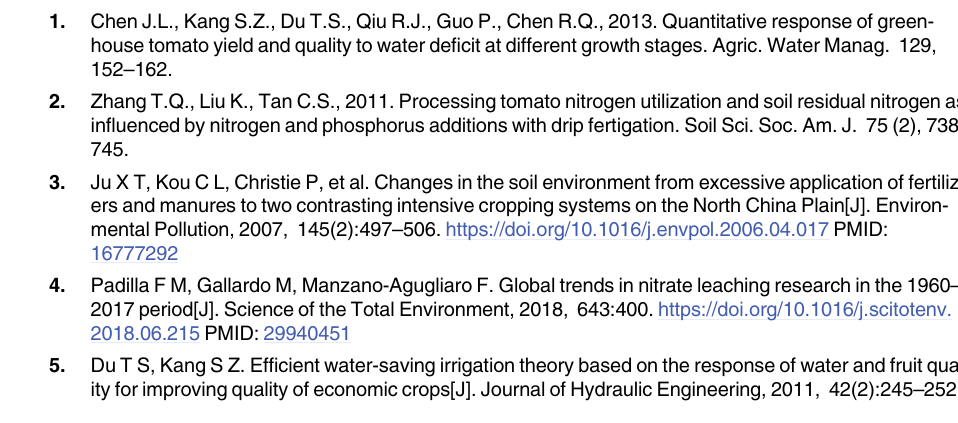
S2 Table. Single fruit weight and fruit number per plant of the same combination of W and K as affected by the growth stages of its